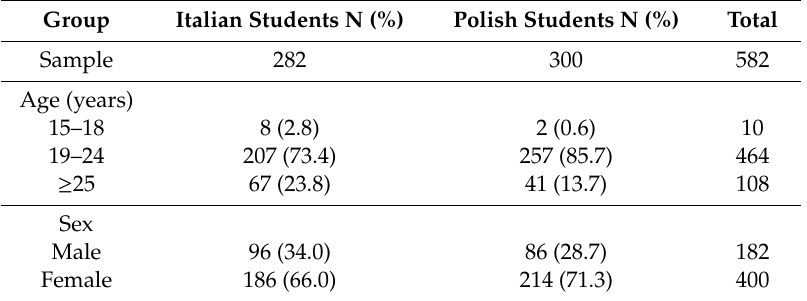
Table 1. Description of the